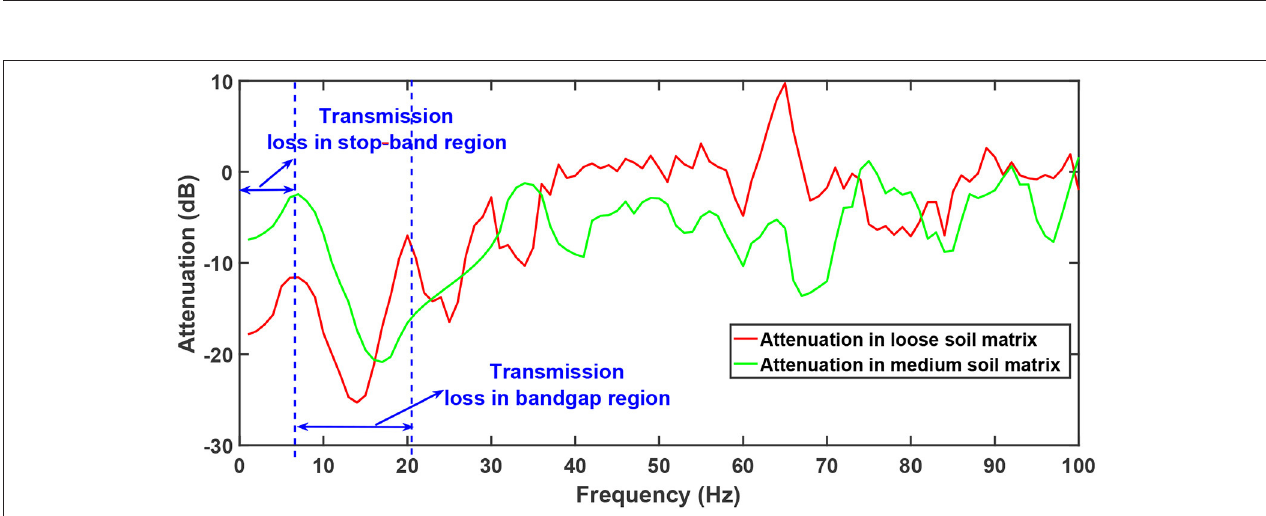
FIGURE 11 | Attenuation for clamped configuration of square concrete columns having dimension 2 × 2 × 10 m in soft soil type 1 (E = 10 MPa, µ = 0.25, and ρ = 1,400 kg / m 3 ) and medium soil (E = 153 MPa, µ = 0.33, and ρ = 1,800 kg / m 3 ) matrix having dimension 3 × 3 × 10 m (substitution ratio 0.445). Clearly, loss in soft soil type 1 matrix is more in comparison to medium